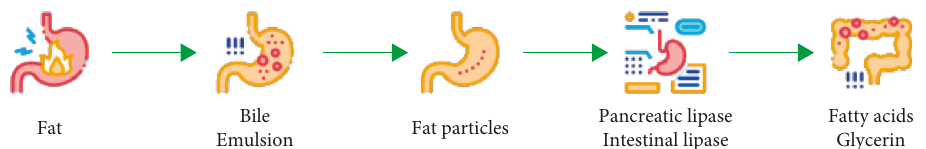
Figure 1: Promoting fat metabolism of college